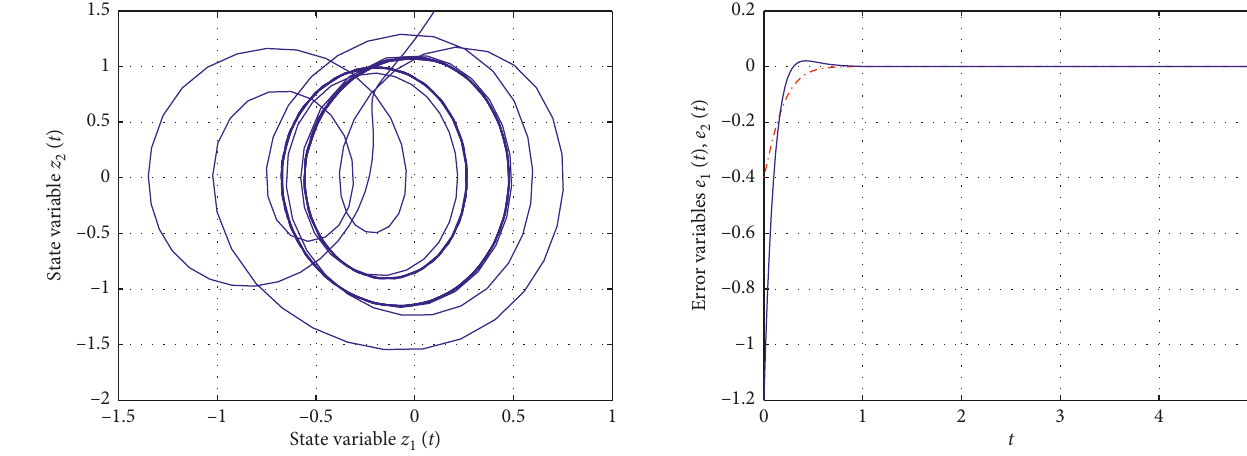
Figure 7: The simulation result for the slave system with k � 1 . 72 ,k � 0 , and k � 1 . 72. 1 2 3